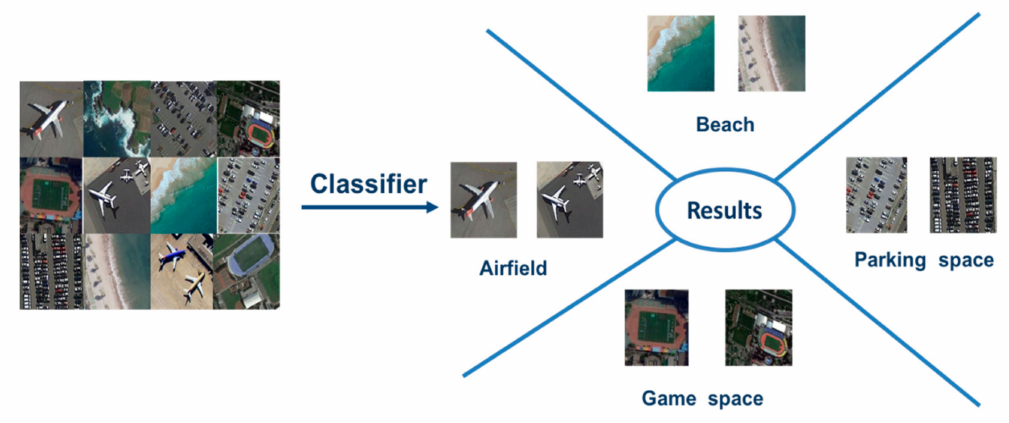
Figure 1. Remote sensing scene